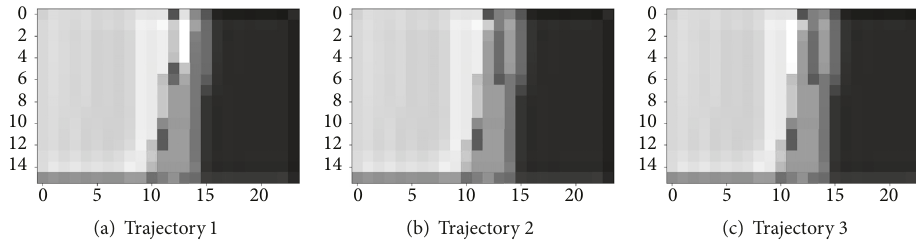
Figure 12: The 𝐺𝑈 representation in different trajectory 4 of the line tracing